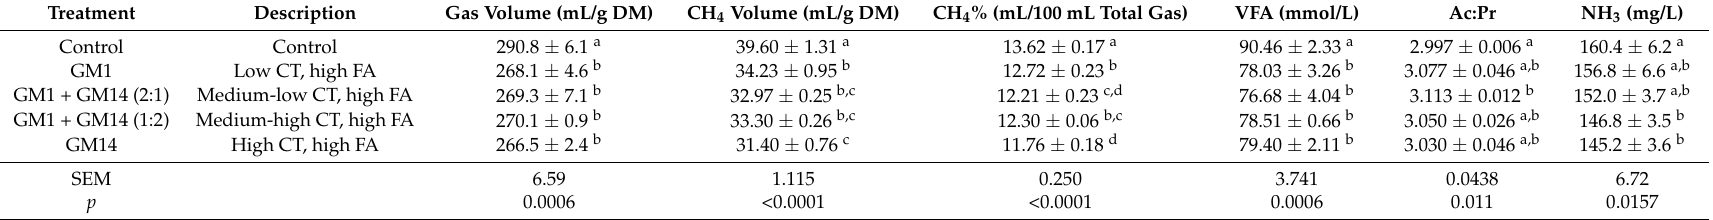
Table 5. In vitro fermentation parameters for Experiment 4; gradient of grape marc samples with differing condensed tannin concentration. Treatment